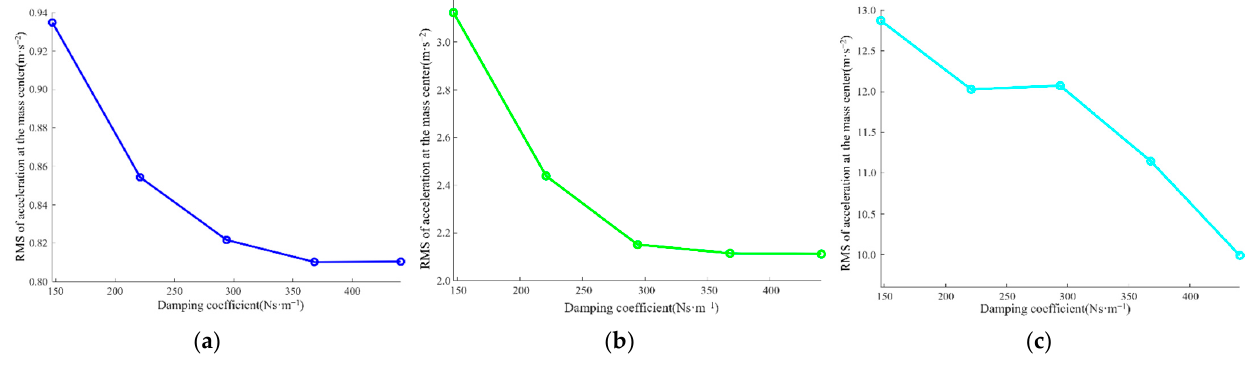
Figure 14. Damping change simulation comparison with bow waves. ( a ) The amplitude of 0.1 m; ( b ) the amplitude of 0.25 m; ( c ) the amplitude of 0.4 m.